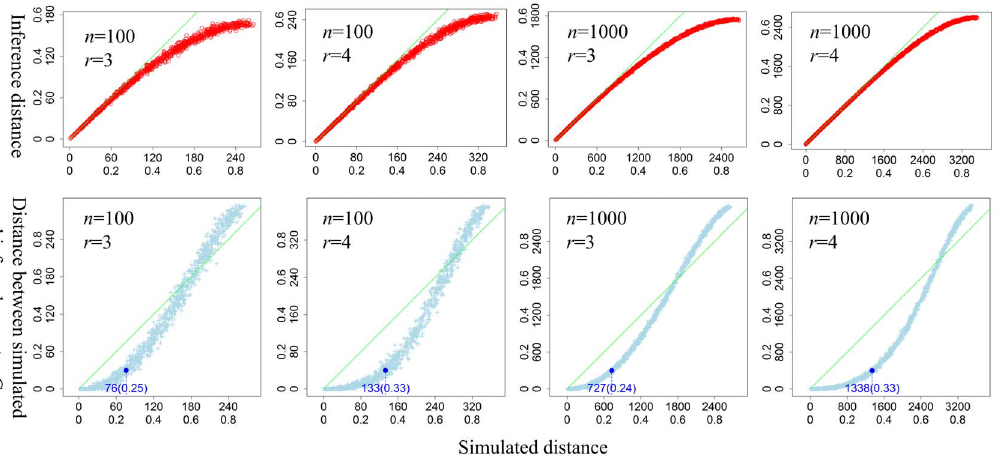
Figure 5. Application of the heuristic algorithm to four simulation datasets. Each light blue point in each panel corresponds to a data point. Green line: x=y. Inner axis labels represent DCJ distance, whereas outer labels show relative DCJ distance. The Y value of the dark blue dot is 0.1 (relative DCJ distance) in each plot, where n is the number of gene families and r is the duplicated size of G obs , and the blue numbers (DCJ distance and relative DCJ distance) below each blue cycle represent the corresponding X values. Note that the inferred and simulated distances are almost the same when the relative simulated distance is smaller than 0.4. The distance is less than 0.1, until the relative simulated distance increases to approximately 0.6. The relative DCJ distance between simulated and inferred G dup is small when the simulated distance is smaller than 0.25 ( r =3) or 0.33 ( r =4).